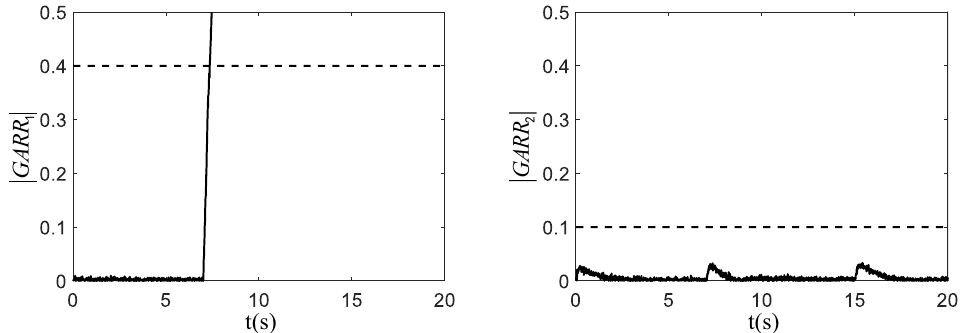
Figure 5. Responses of residuals in the second fault scenario.